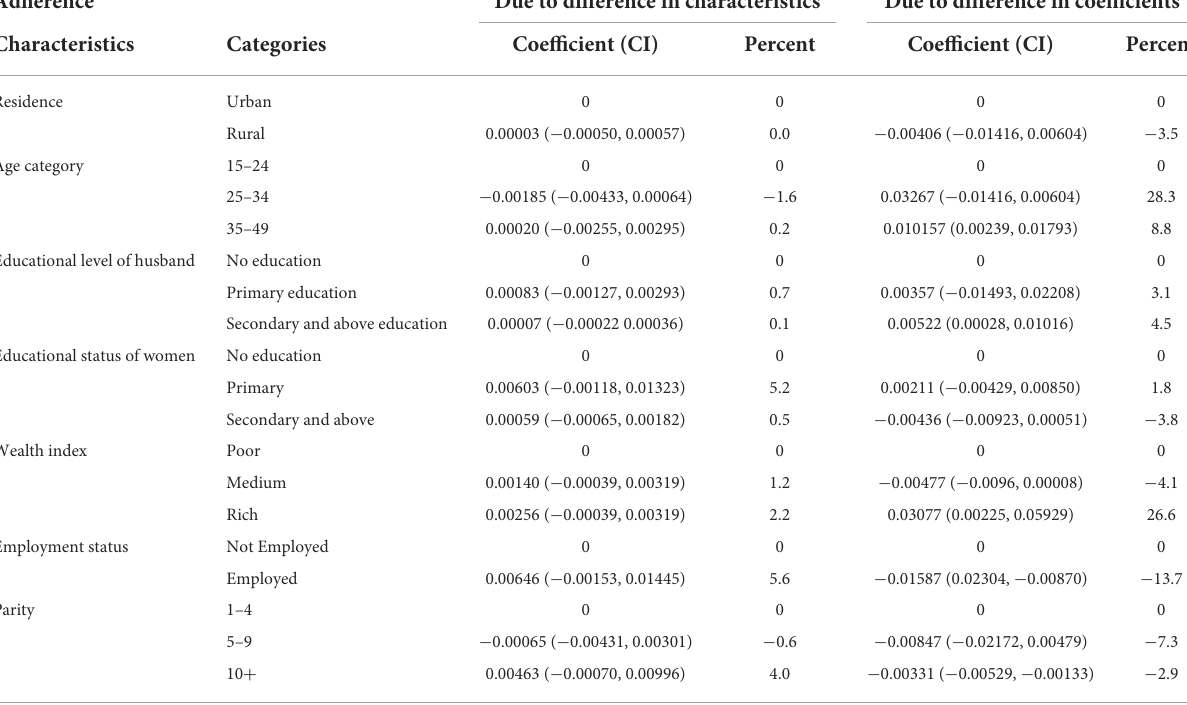
TABLE 5 Decomposition analysis of changes in adherence levels to iron supplements during pregnancy based on the EDHS 2005–2016. Adherence